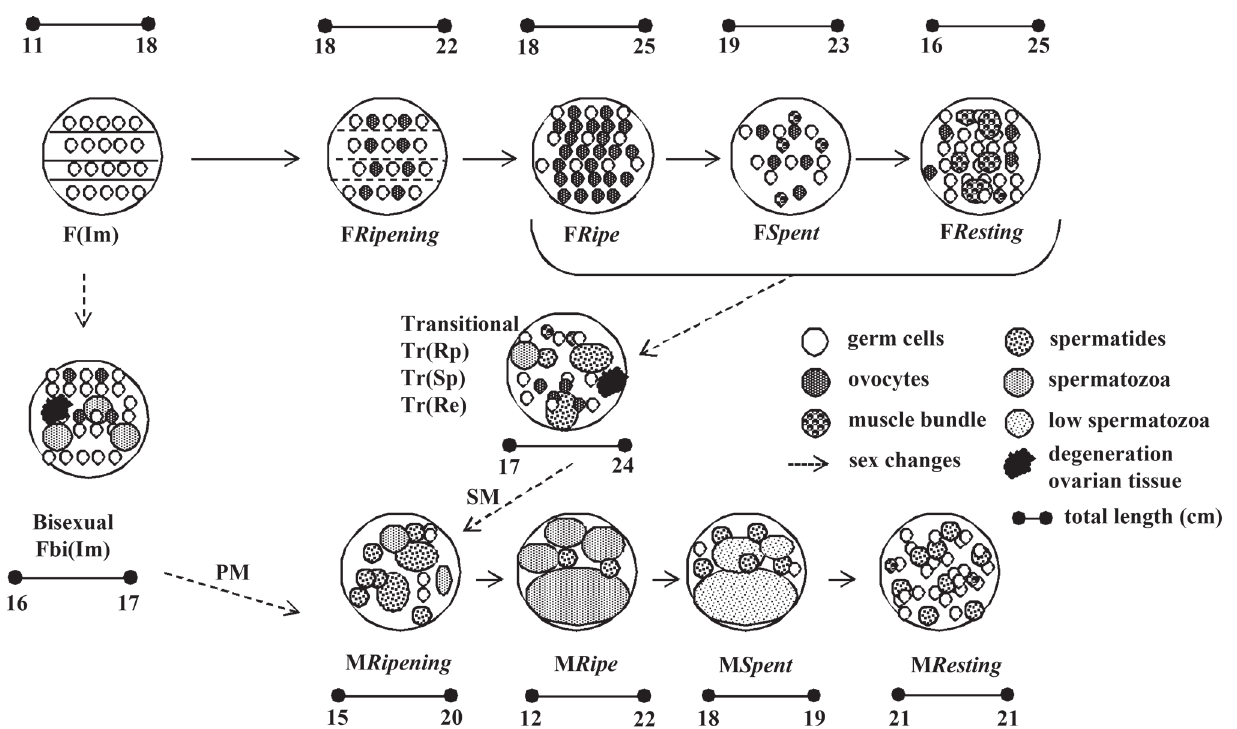
Fig. 10. Pathways of the reproductive cycle of Alphestes afer showing the steps of protogynous hermaphroditism steps according to histological evidences observed. The schematic figures represent a portion of the histological section observed in microscopic. Fbi (Im), immature bisexual female; Tr(Rp), transitional ripe; TR(Sp), transitional spent; TR(Re), transitional resting; PM, primary male; SM, secondary